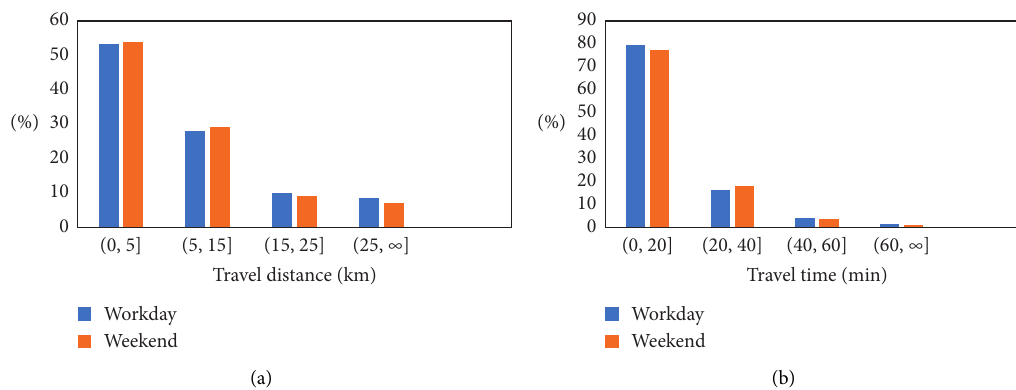
Figure 3: The statistical characteristics of trajectories on workdays and weekends: (a) the proportion of trajectories in different travel distance intervals and (b) the proportion of trajectories in different travel time intervals.